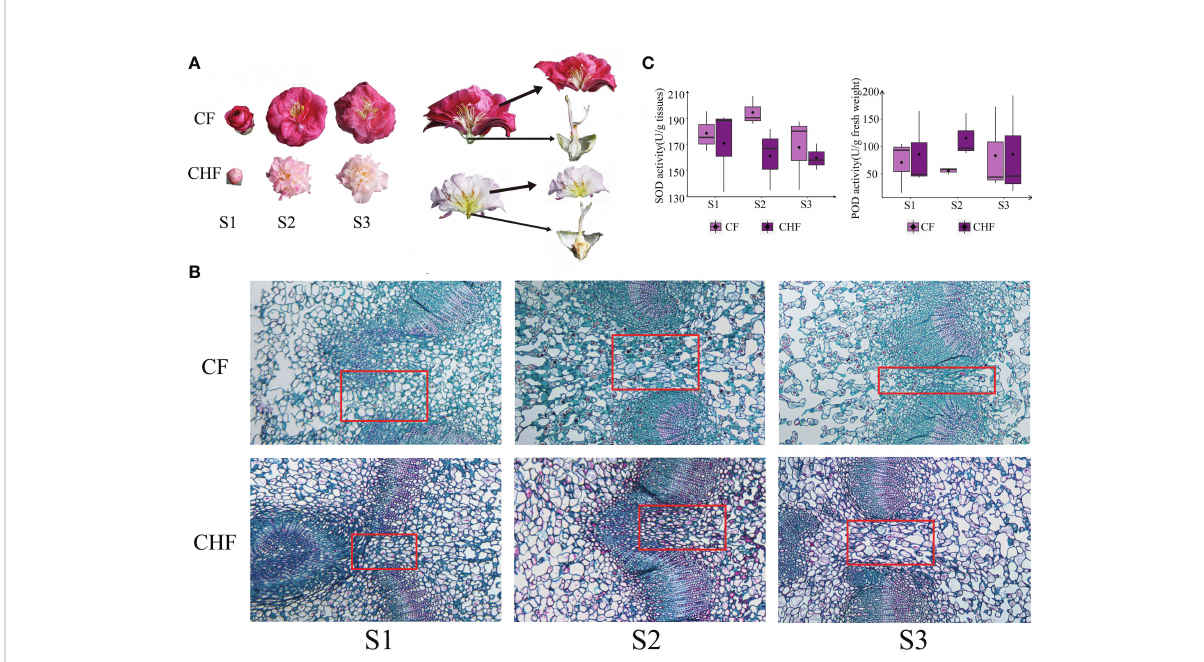
FIGURE 1 Morphology and enzymatic activity assessment of camellia. (A) The receptacles and petals of CF and CHF fl owers are depicted individually. (B) Histological structure of Camellia at different stages at a fi nal magni fi cation of 400X. The red box is where the representative structure sites of the abscission features. (C) Determination of SOD and POD enzymatic activity at the S1, S2, and S3 phases of CF and CHF. There was no signi fi cant difference among different